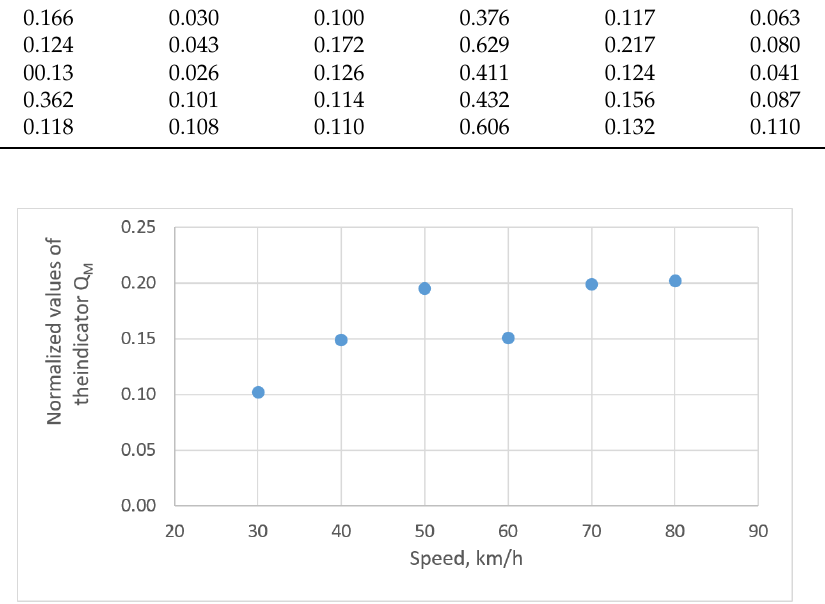
Figure 28. Normalized Q M values according to the running speed.